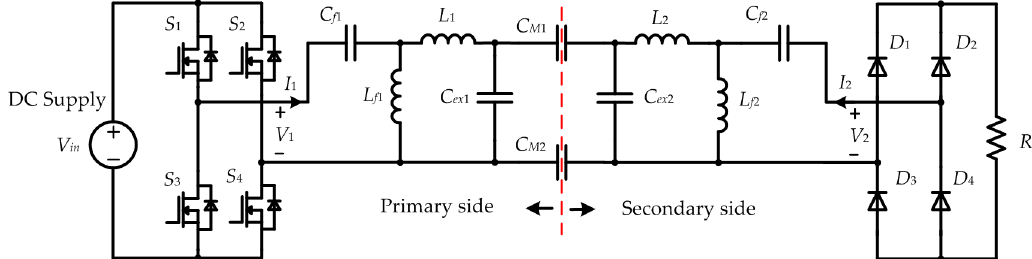
Figure 19. Circuit topology of a CPT system based on full-bridge inverter with double-sided CLLC compensation.